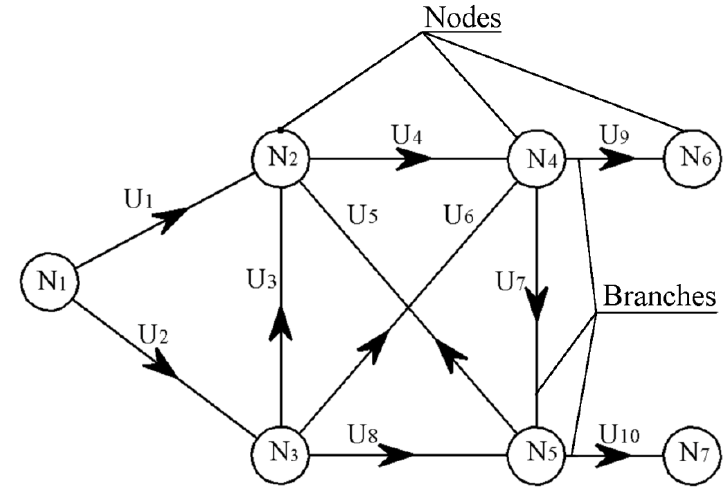
Figure 1. Example of a directed graph.